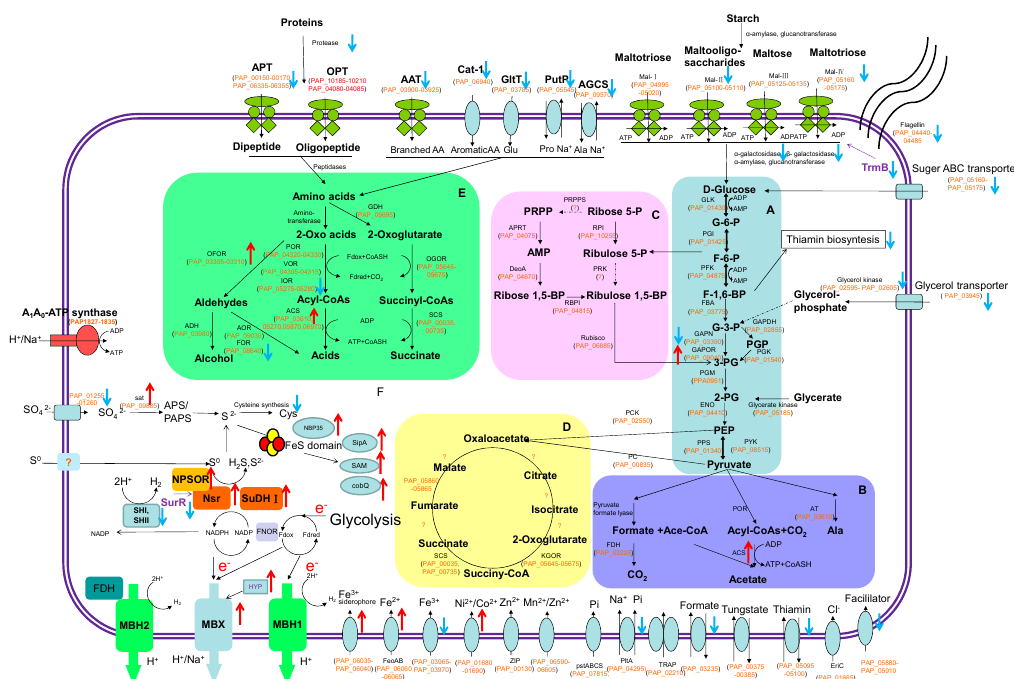
Figure 2. General metabolism and elemental sulfur-mediated cellular responses in Palaeococcus pacificus DY20341 T